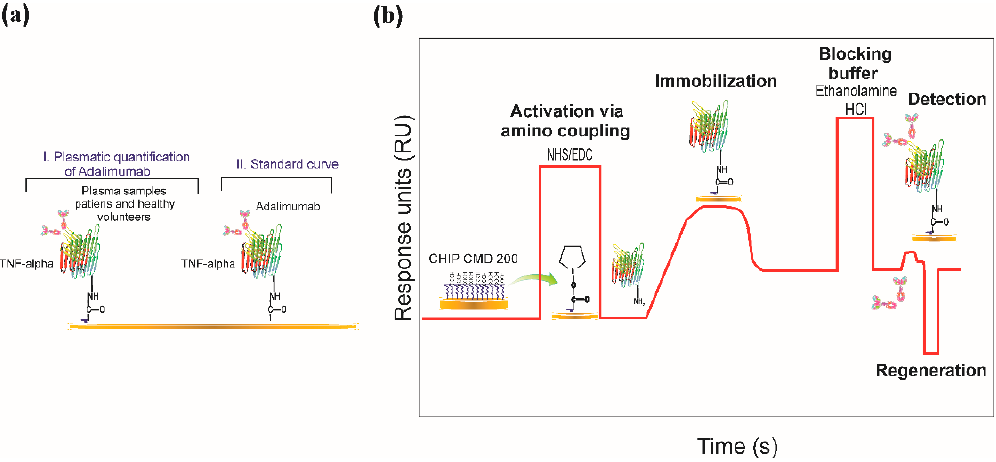
Figure 1. Schematic overview of the direct bioassay. ( a ) Schematic representation of activation via amino coupling on the CMD 200 surface. Carboxyl groups have been activated for covalently immobilising the TNF- α protein. Ab anti-TNF- α is detected once the protein has been immobilised. (I) Plasma samples from patients taking adalimumab and their controls; (II) Procedure for obtaining adalimumab spiked calibration curve in vitro. ( b ) A typical sensorgram obtained by SPR, showing all the stages involved in adalimumab quantification.